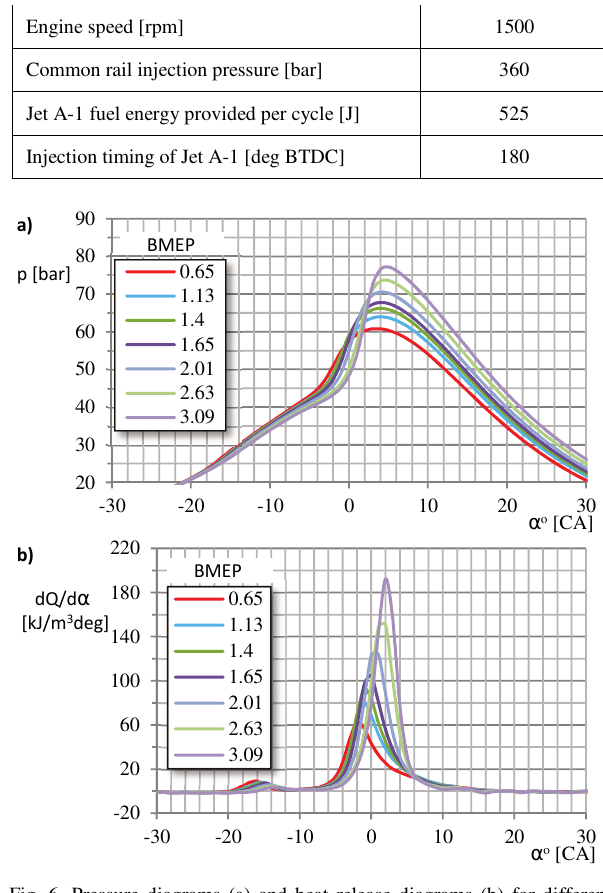
Fig. 5. Pressure diagrams (a) and heat release diagrams (b) for different engine load and constant engine speed (1500 rpm) for dual fueling with Jet A-1 and propane (PCCI mode) Table 6. Engine adjustment parameters for dual fueling with Jet A-1 and propane for HCCI mode